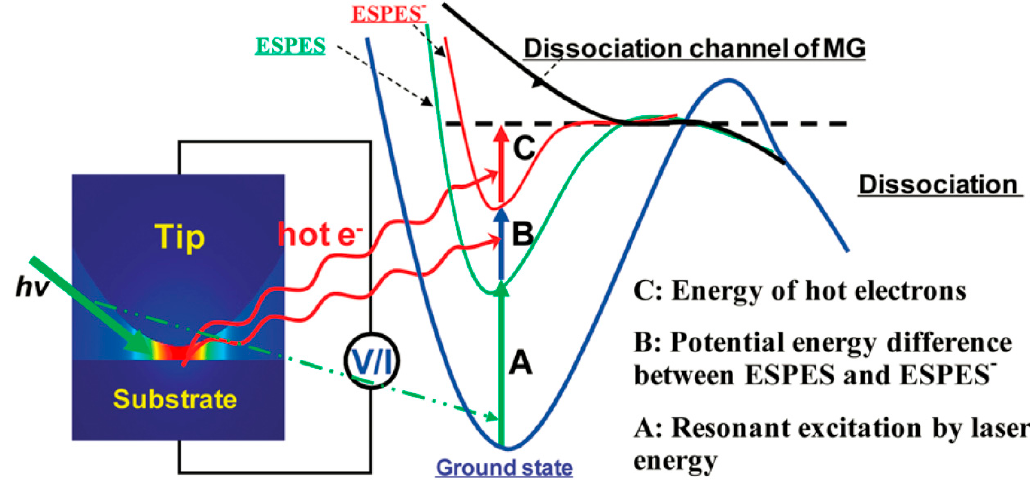
Figure 7. The mechanism of resonant dissociation by plasmon scissors. Three main energetic components drive the chemical reaction: ( A ) resonant absorption of the laser light enhances the vibrational modes associated with − NC 2 H 6 and excites the MG molecules to an excited-state potential energy surface (ESPES); ( B ) hot electrons temporarily change the molecules’ ESPES from a neutral to a negative ion excited state (ESPES − ); ( C ) the kinetic energy of the hot electrons is converted into intramolecular vibrational thermal energy. Adapted from [9].